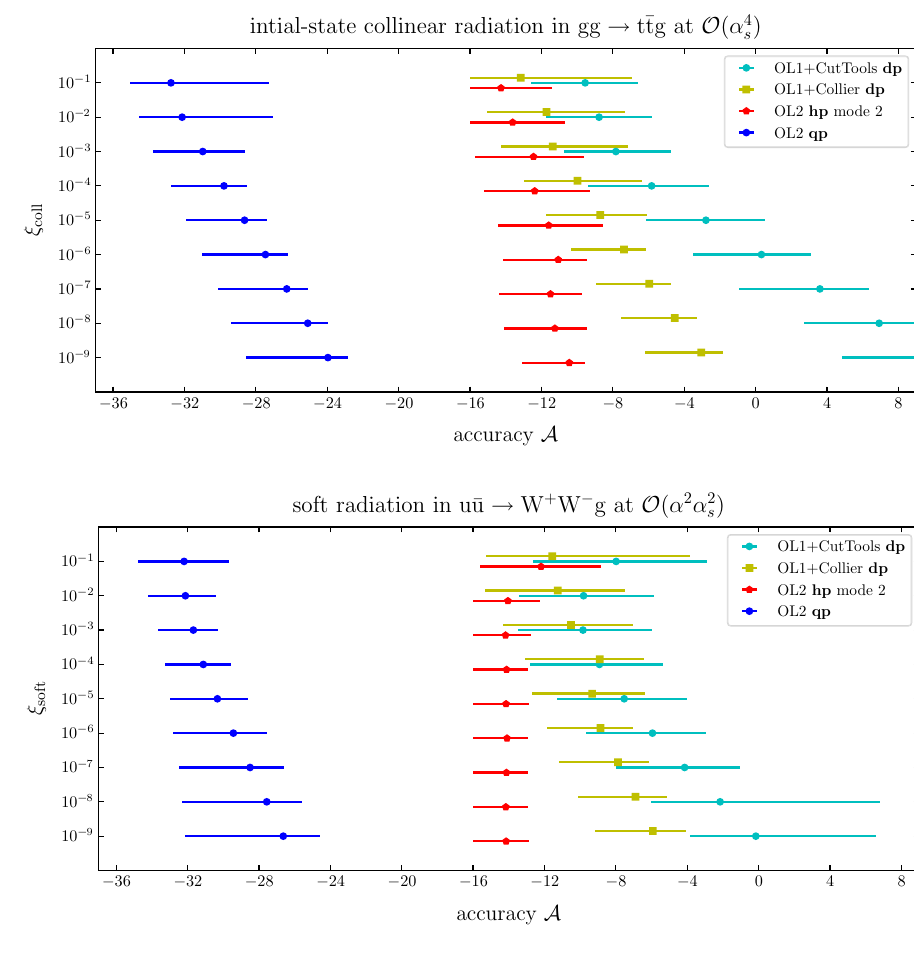
Fig. 6 Relative numerical accuracy A for gg → t ¯ tg (upper plot) and u ¯ u → W + W − g (lower plot) at NLO QCD versus the degree of collinear ( ξ coll ) or soft singularity ( ξ soft ) as defined in (5.2). For each value of ξ coll / soft the numerical accuracy is estimated with a sample of 10 4 randomly distributed underlying 2 → 2 hard events. The plotted central points and variation bands correspond, respectively, to the average and 99 . 9% confidence interval of A . Quad-precision benchmarks (blue) are compared to OpenLoops 2 with additional hybrid-precision improvements for IR regions ( hp_mode=2 , red) and also to OpenLoops 1 with Collier (yellow) or CutTools (turquoise) in